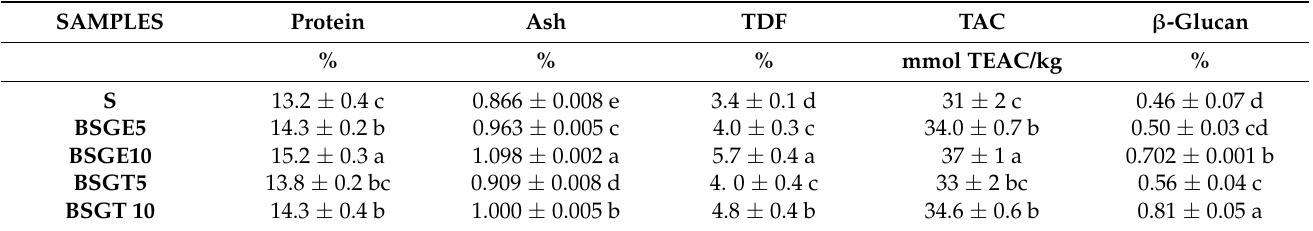
Table 2. Basiccomposition of control pasta (S) and brewers’ spent grain (BSG) enriched pasta (BSGE5, BSGE10, BSGT5 and